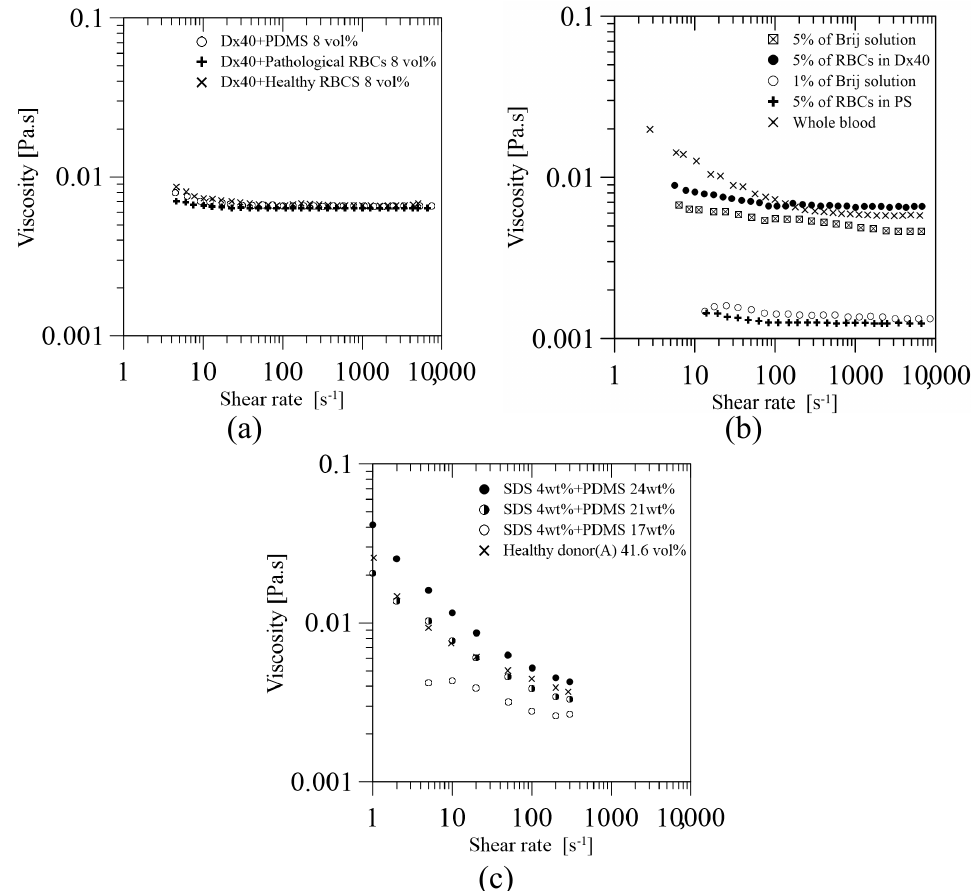
Figure 6. Steady shear viscosity curves as a function of the shear rate obtained by: ( a ) Pinho et al. [46], ( b ) Carneiro et al. [52], and ( c ) Lima et al.